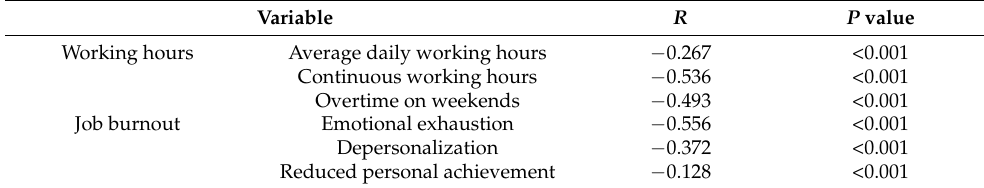
Table 3. Correlation analysis between working hours, job burnout, and subjective well-being in hospital administrators.